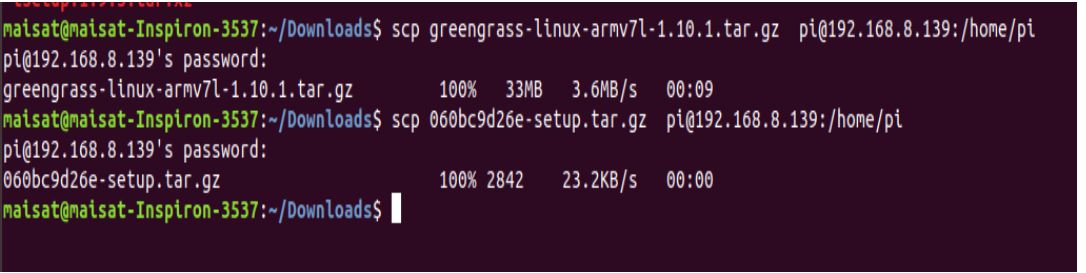
Figure 8. Modified device policy to include the edge layer in the proposed model.